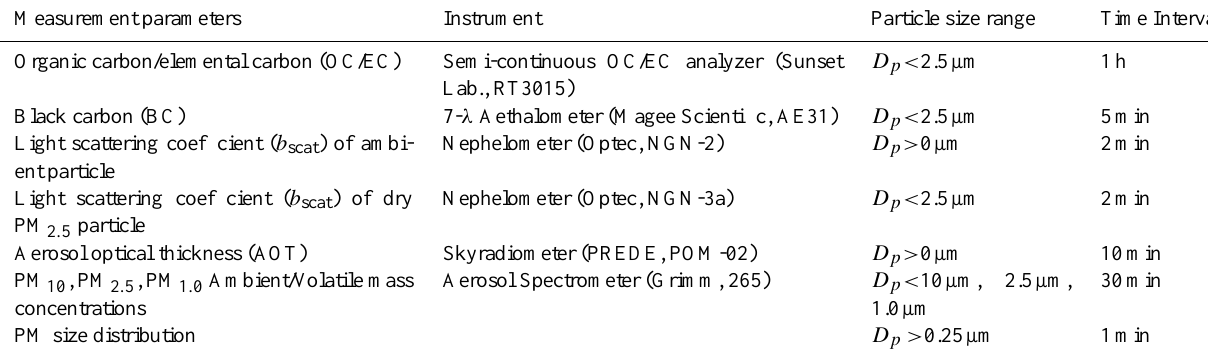
Table 1. Measurement parameters and instrument conditions used in this study.